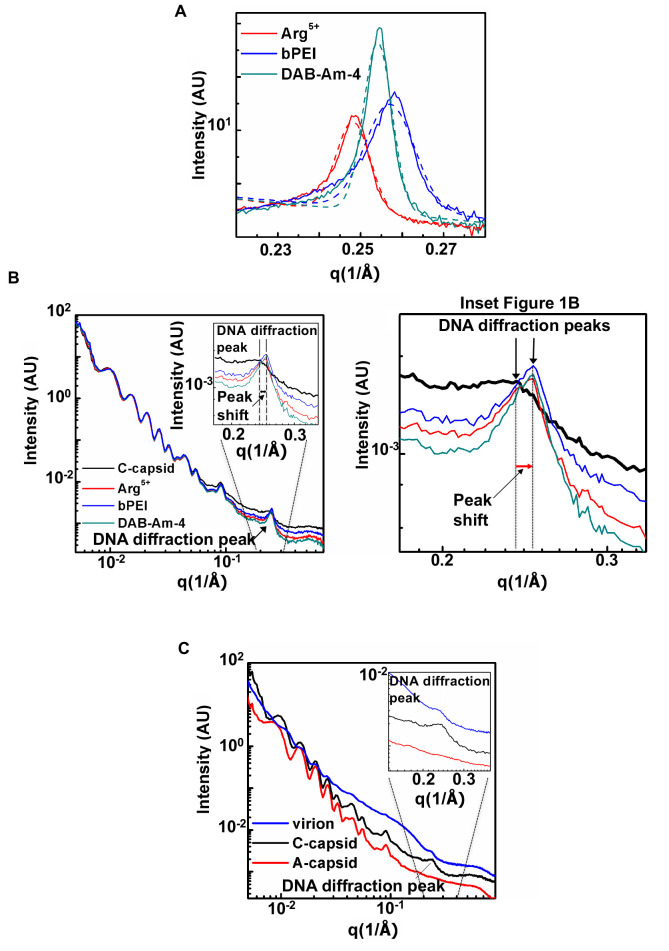
(A) Integrated X-ray scattering intensity, I, versus scattering vector q for free DNA condensed in TM buffer with added compounds DAB-Am-4, bPEI 600, and Arg5+. Compound concentrations corresponded to the N/P ratio of 1.5 required for DNA condensation. Data were collected at 15, 23, and 37°C but are only shown at 37°C (relevant to infection temperature). (B) Integrated X-ray scattering intensity, I, versus scattering vector q for C-capsids in TM storage buffer without and with added compounds DAB-Am-4, bPEI 600, and Arg5+ at 37°C. Compound concentrations corresponded to the N/P ratio of 1.5 required for DNA condensation. The single peak at higher q (between 0.2 Å-1 to 0.3 Å-1) is due to the diffraction from the encapsidated ordered DNA strands. The position of the DNA diffraction peak shifts to higher q values when any of the three DNA condensing compounds are added (shown in the Figure inset), indicating that the interaxial distance between packaged DNA strands decreases. (C) SAXS analysis of DNA-DNA spacing in HSV-1 A-capsid, C-capsid, and virion (C-capsid with tegument and lipid envelope). Radially averaged scattered intensity versus the scattering vector q for HSV-1 virion (blue curve), C-capsid (black curve), and A-capsid (red curve) at 37 ºC. The inset figure shows a zoomed-in region of the DNA diffraction peak observed for DNA-filled C-capsid and virion. The buffer background was subtracted in (A), (B), and (C). AU, arbitrary units.